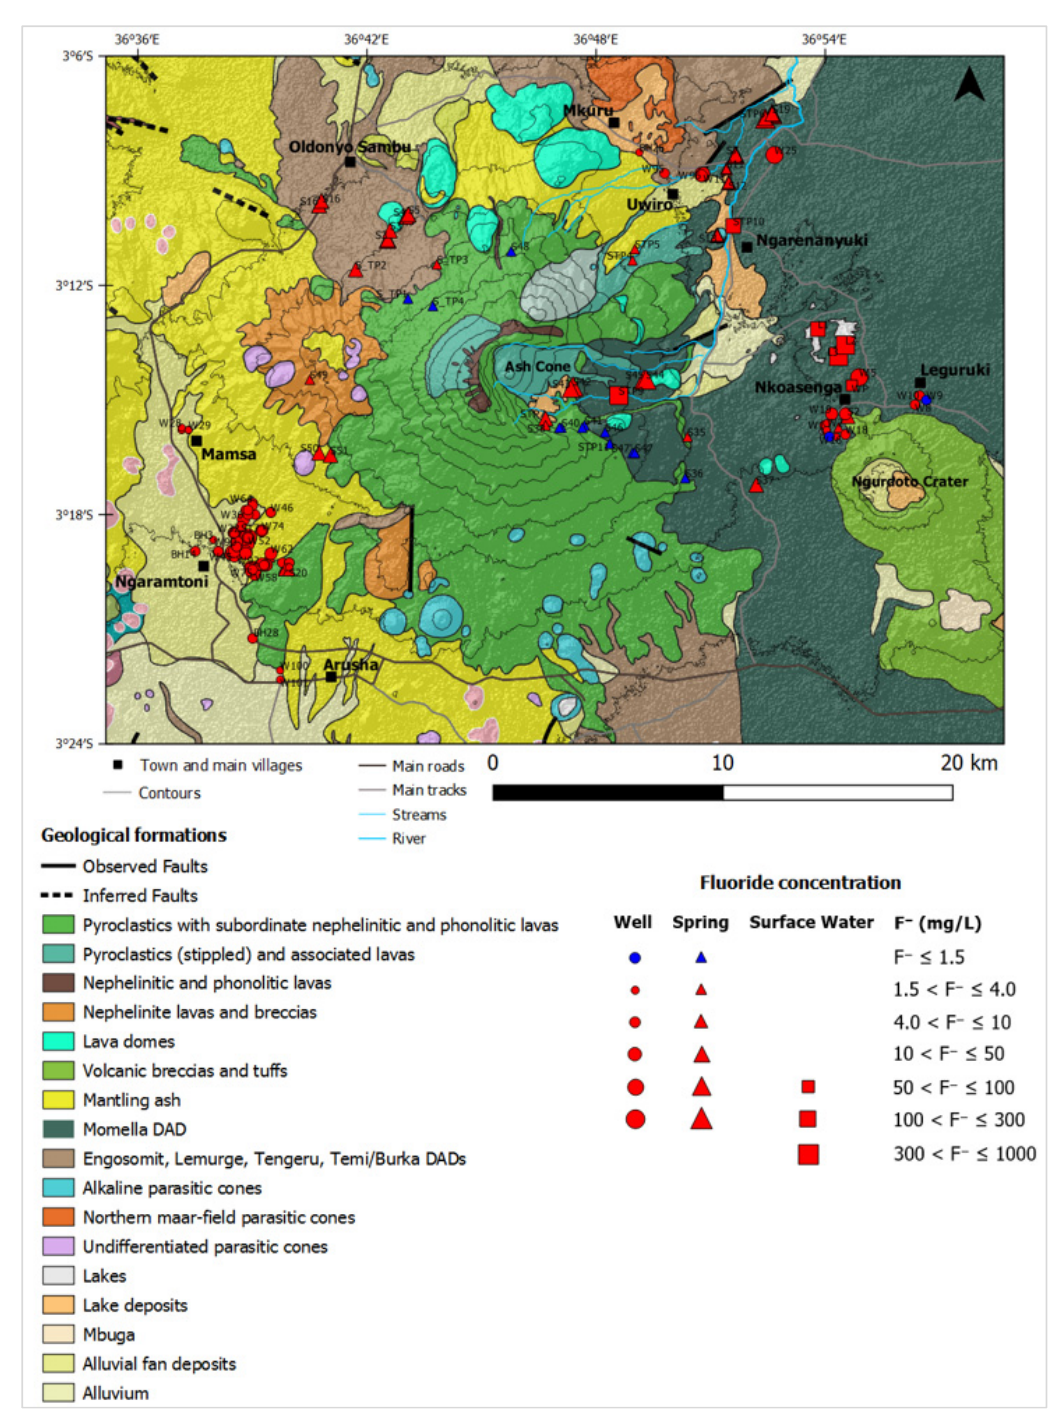
Figure 3. Geological map of the study area (modified after Wilkinson et al. [23] and Delcamp et al. [20]), indicating different geological formations and spatial distribution of F ⁻ concentrations of sampled water points. The geological descriptions are based on Wilkinson et al. [23] with updates from Delcamp et al. [20], who re-interpreted the deposits that had originally been mapped as lahar, as debris avalanche deposits (DADs). The deposits that had originally been mapped as tholoids by Wilkinson et al. [23] are now re-interpreted as lava domes in this study.